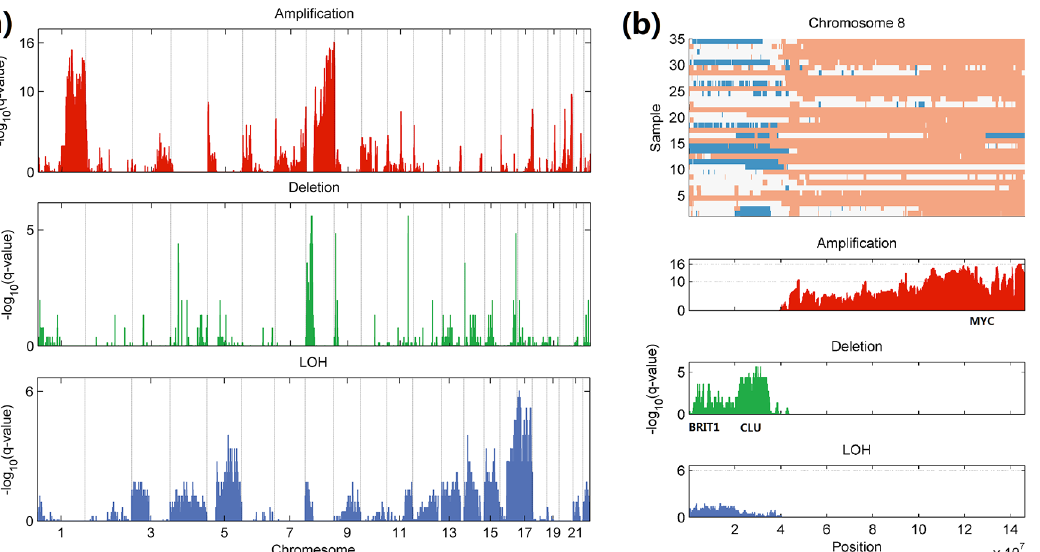
Fig 7. Genome-wide analysis of statistically significant aberrations on a collection of breast tumors. (a) Statistical significance for amplification (red), deletion (green) and LOH (blue) are evaluated by q-value. (b) Detailed visualization of aberration profiles of amplification(red)/deletion(blue) and statistical significance on chromosome